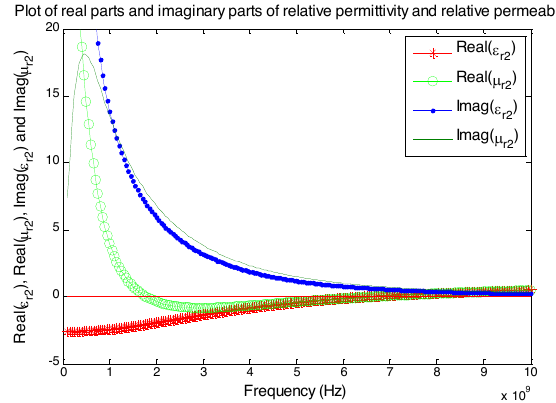
FIGURE 9. Real and imaginary parts of relative permittivity, ε r2 , and relative permeabilility, µ r2 , of Rings and rods media versus frequency for γ m =